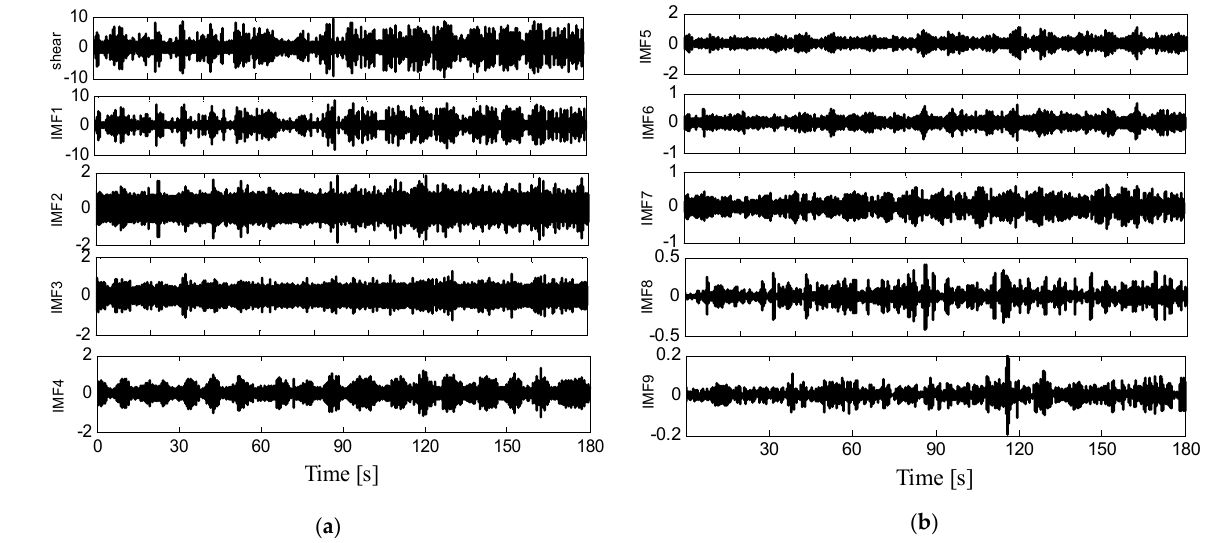
Figure 3. Comparison of the raw velocity shear signals and the IMF modes. ( a ) The raw velocity shear signals and the IMF modes from IMF1 to IMF4; ( b ) The IMF modes from IMF5 to IMF9. In Figure 3, each IMF modes has its own time scales and frequency. IMF1–IMF9 represent the different parts of the original ocean turbulence shear signal with the frequency from high to low. The time scales of the nine IMF modes become larger as the orders increase, while the frequency and amplitudes become smaller. The variation tendency of IMF1 is the most similar to the original shear signals. Frequency comparison of the raw velocity shear signals and the decomposed IMF modes is shown in Figure 4. The horizontal axis represents the frequency and the vertical axis represents the amplitude.